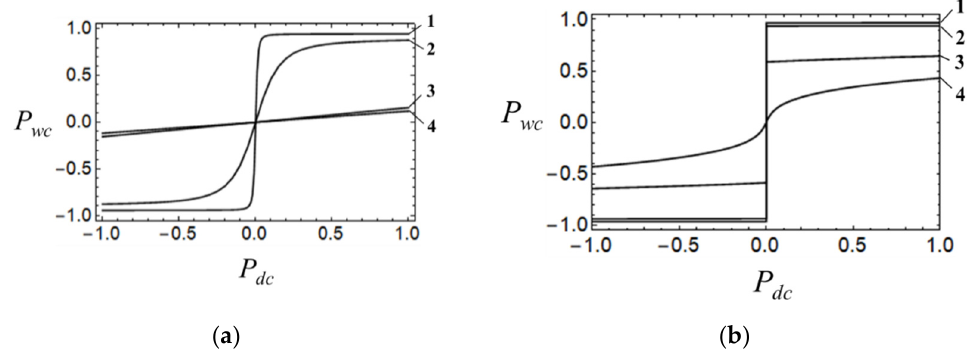
Figure 6. Cell-cell response functions calculated in the framework of quantum-mechanical ( a ) and semiclassical ( b ) vibronic approaches for the following four values of the vibronic coupling param-